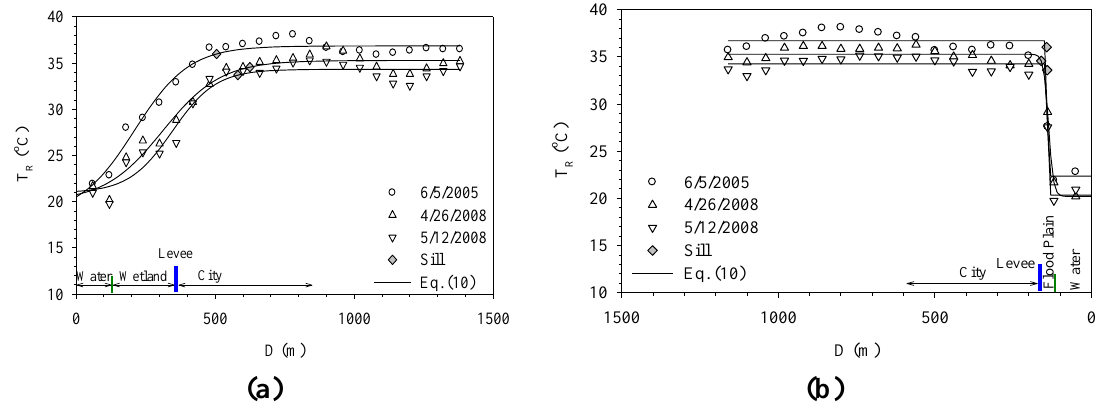
Figure 7. Temperature variation profiles of right bank ( a ) and left bank ( b ) of Xin-Hai